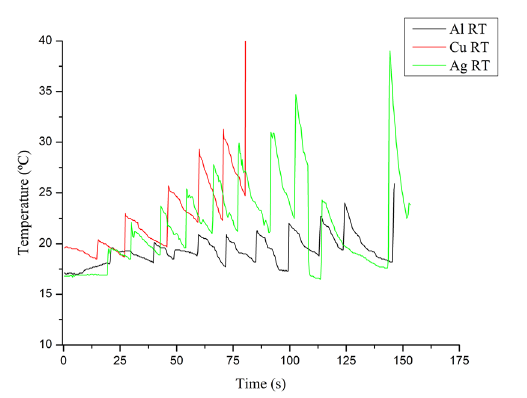
Figure 1. Temperature variation during RT rolling processes for Al, Cu and Ag.